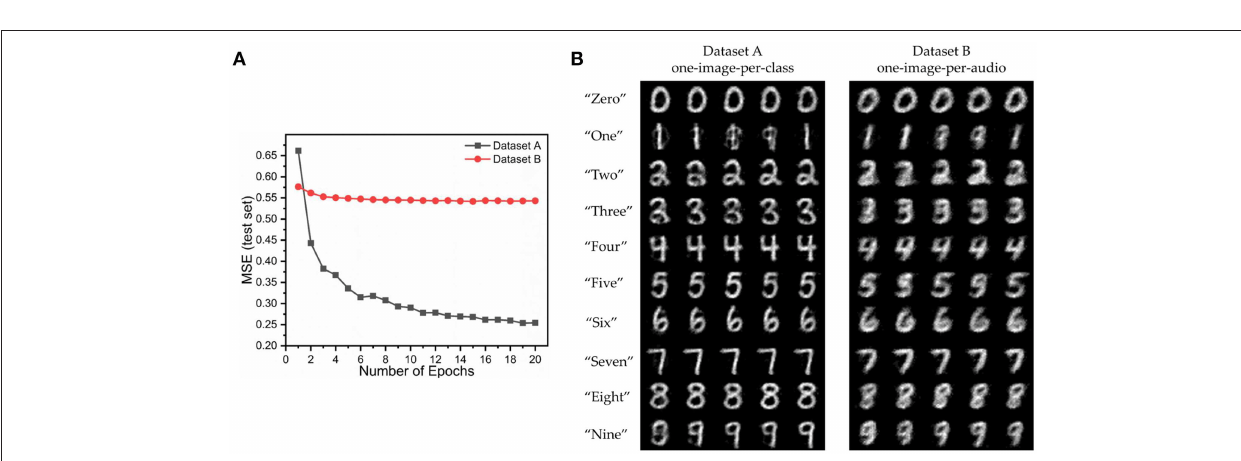
2. Dataset B : Each audio sample of the training set is paired with a randomly selected image (of the same label) from the MNIST dataset (one-image-per-audio-sample). Every audio sample is paired with a unique image of the same